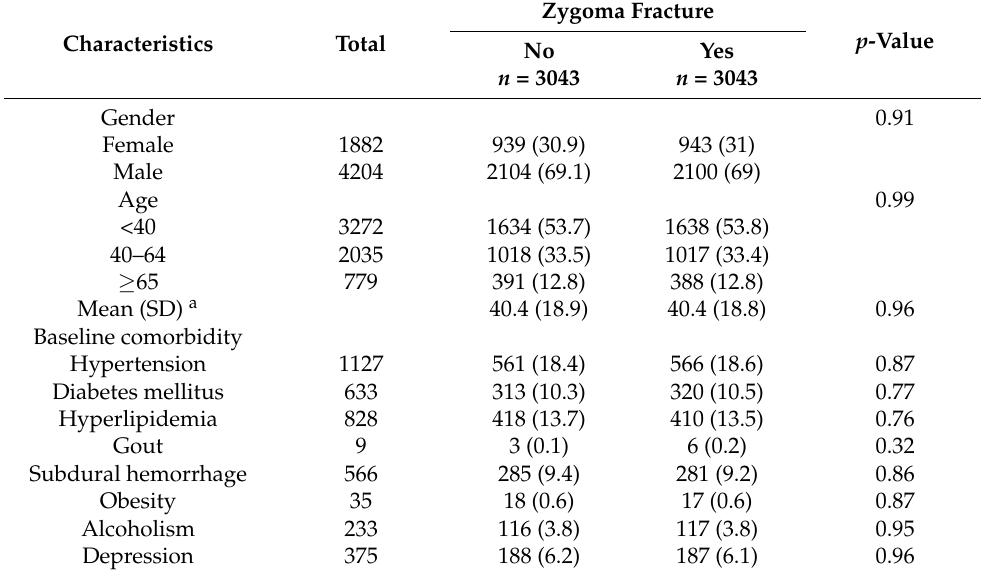
Table 1. Demographic characteristics and comorbidities of patients newly diagnosed zygoma fracture in Taiwan during